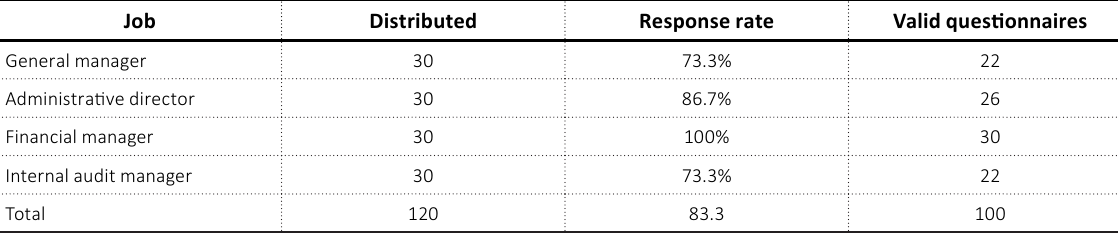
Table 1. Valid, collected and distributed questionnaires